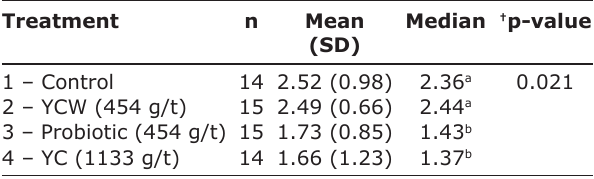
† Fisher’s exact test. a Percentages with a superscript in common do not differ with a level of significance of 5% when using the Bonferroni multiple comparison procedure Table-2: Summary of Salmonella log most probable 10 number/g in culture-positive ceca samples by treatment. Fifteen individually housed birds were sampled from each treatment group at 7 days